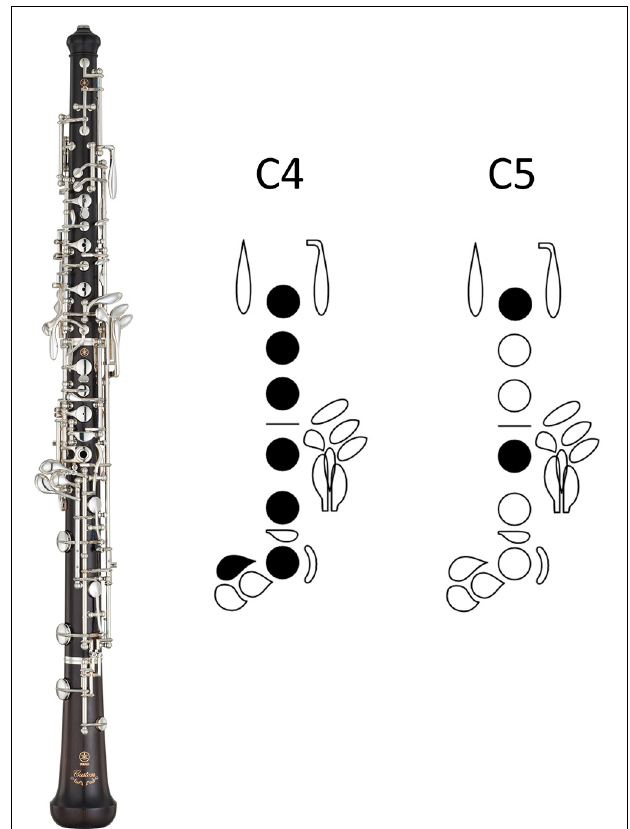
FIGURE 1 | The oboe (left) and fingerings for C4 (middle) and C5 (right). Oboe photograph by Yamaha Music Europe. Graphic created via Fingering Diagram Builder